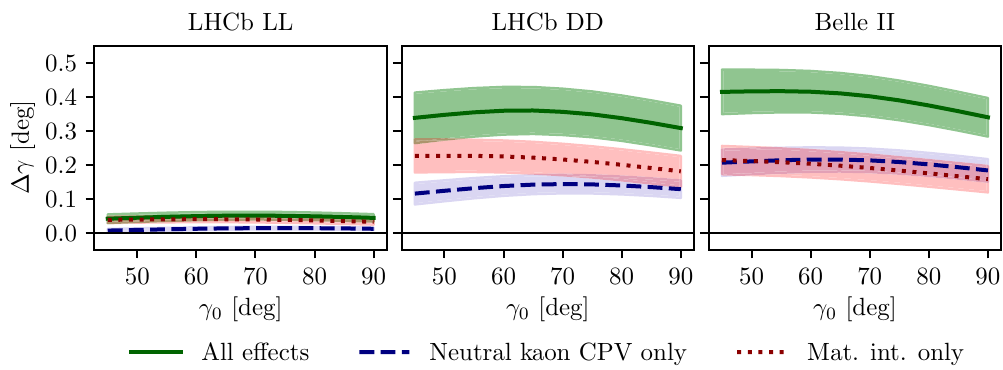
Figure 4 . The bias ∆ γ as a function of input γ 0 for (left) the LL LHCb category, (centre) the DD LHCb category, and (right) Belle II. The bias is calculated due to (blue, dashed line) neutral kaon CP violation alone, (red, dotted line) material interaction alone, and (green line) both effects. The shaded region shows the estimated 1 σ uncertainty